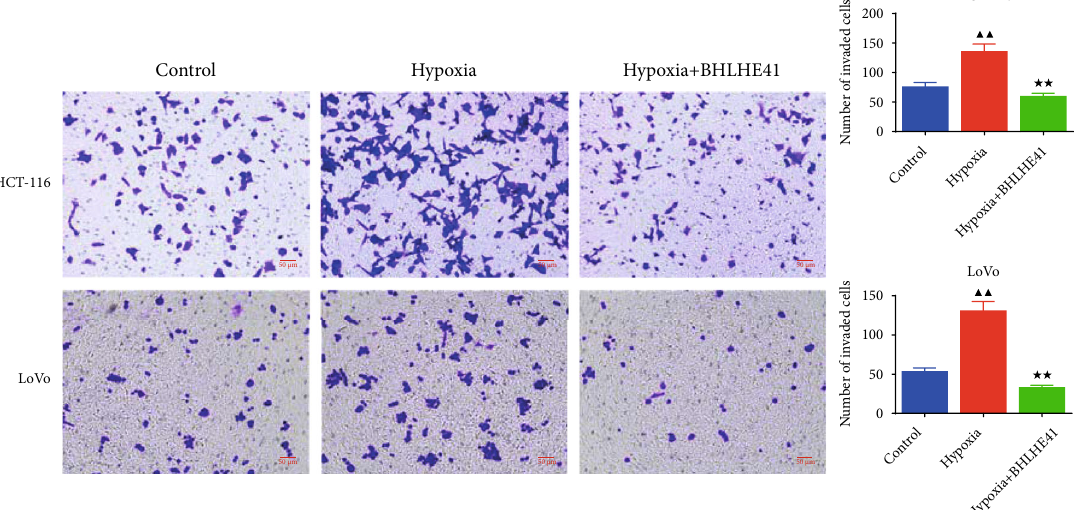
Figure 7: BHLHE41 overexpression repressed the invasion in hypoxia-induced CC cells. The invasion in hypoxia-induced CC cells was tested by Transwell assay. All experiments have been performed in triplicate, and data were expressed as mean ± SD . ∗∗ P < 0 : 01 vs. hypoxia; ▲▲ P < 0 : 01 vs.